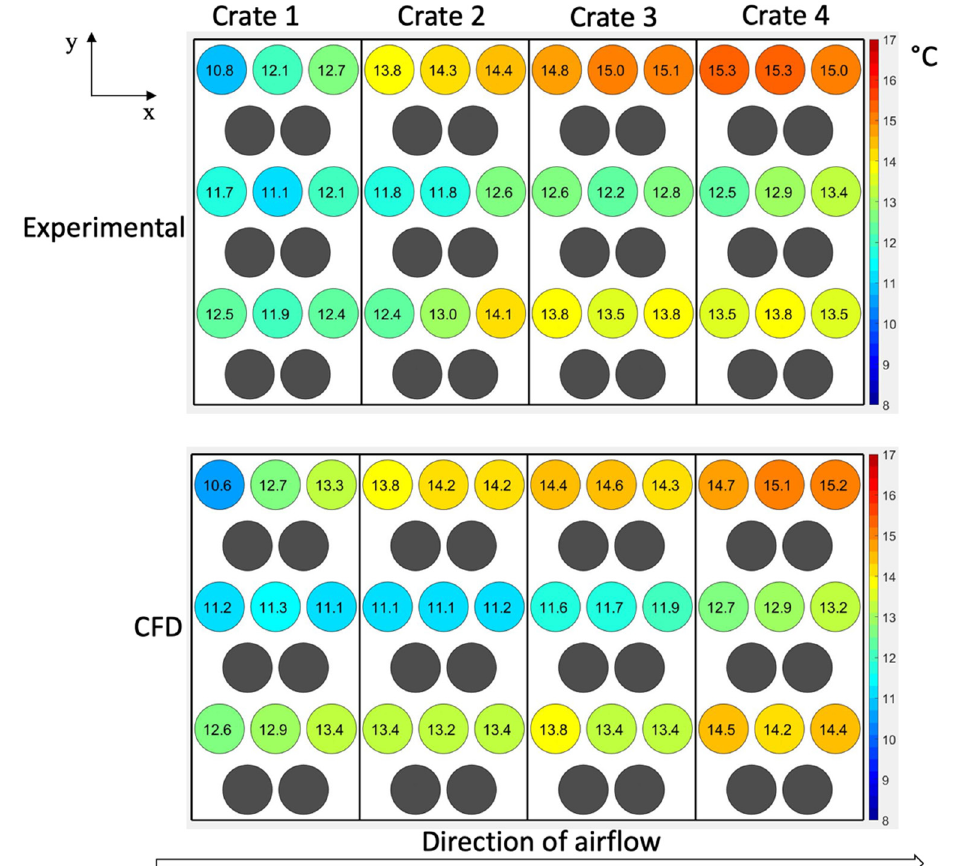
Figure 8. Comparison between experimental and numerical temperatures of the products at half-cooling time for an airflow rate of 0.66 L s − 1 kg − 1 (crate B).